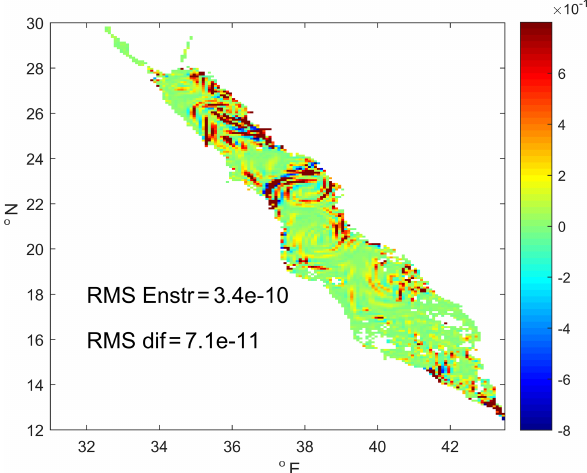
Figure 14. Spatial distribution of differences in surface enstrophy (s − 2 ) between the fine-resolution and medium-resolution models on 1 April of